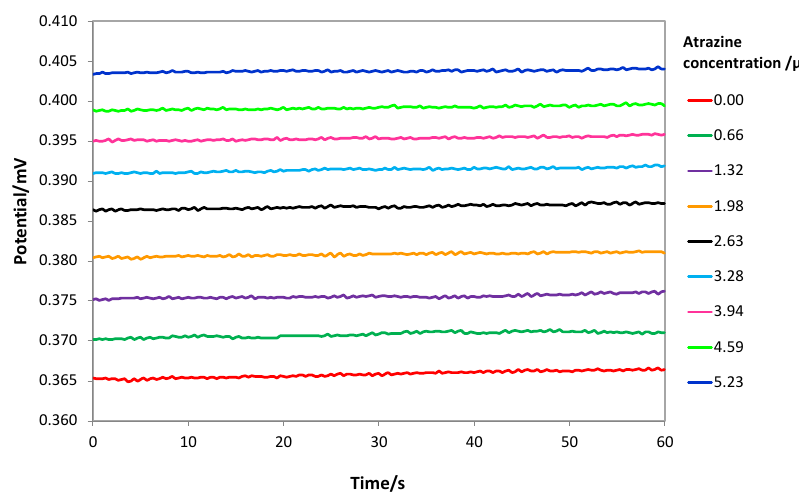
Figure 5. Potentiometric response of a MIP-based screen-printed cell at different atrazine concentrations in HCl solution at pH = 1.5. Steady state reached in 5 min. Cell potential registered in the last 60 s.